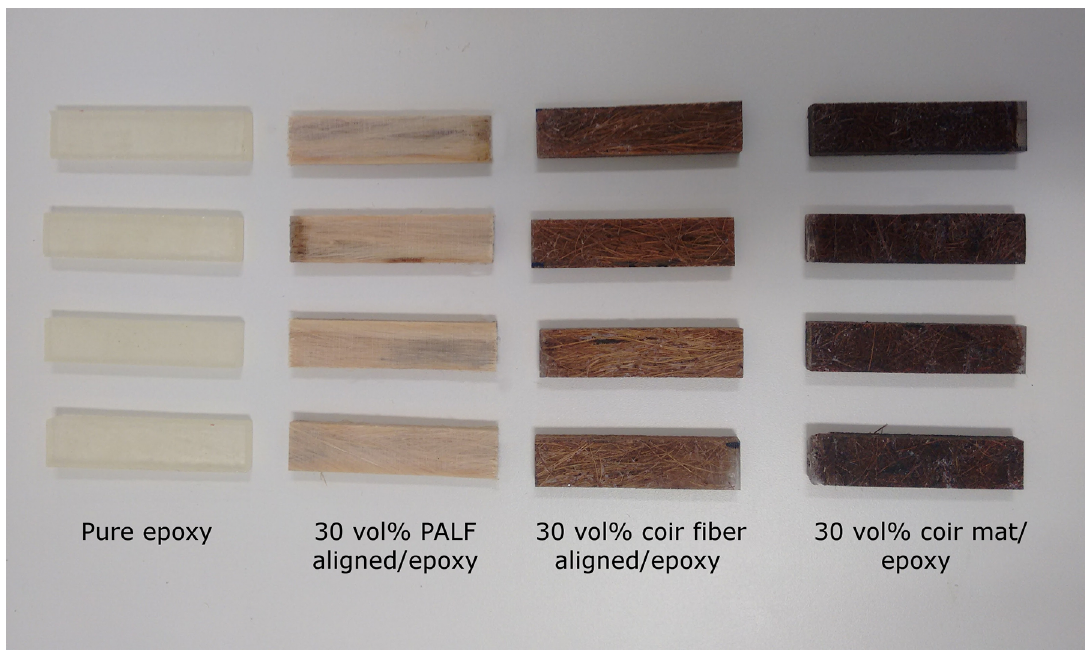
Figure 1. Specimens after cure at room temperature.